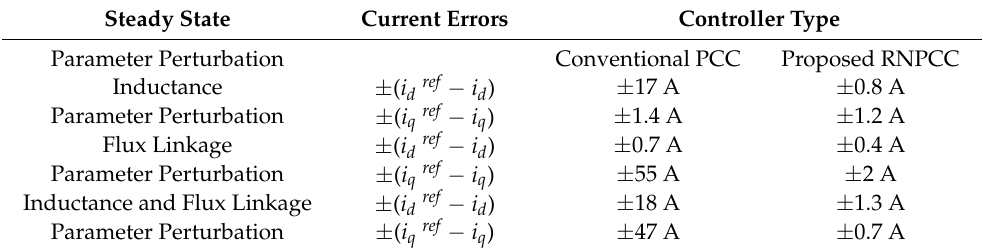
Figure 9. Simulation results of the RNPCC method under inductance and flux linkage parameter perturbations. The comparative performance of the current tracking between the conventional PCC and RNPCC methods was provided as follows. ( a ) d - and q -axis current responses and references.; ( b ) three-dimensional rotor flux trajectories; ( c ) disturbance estimation results. Table 2. Comparison of the current tracking between the conventional PPC and RNPCC.